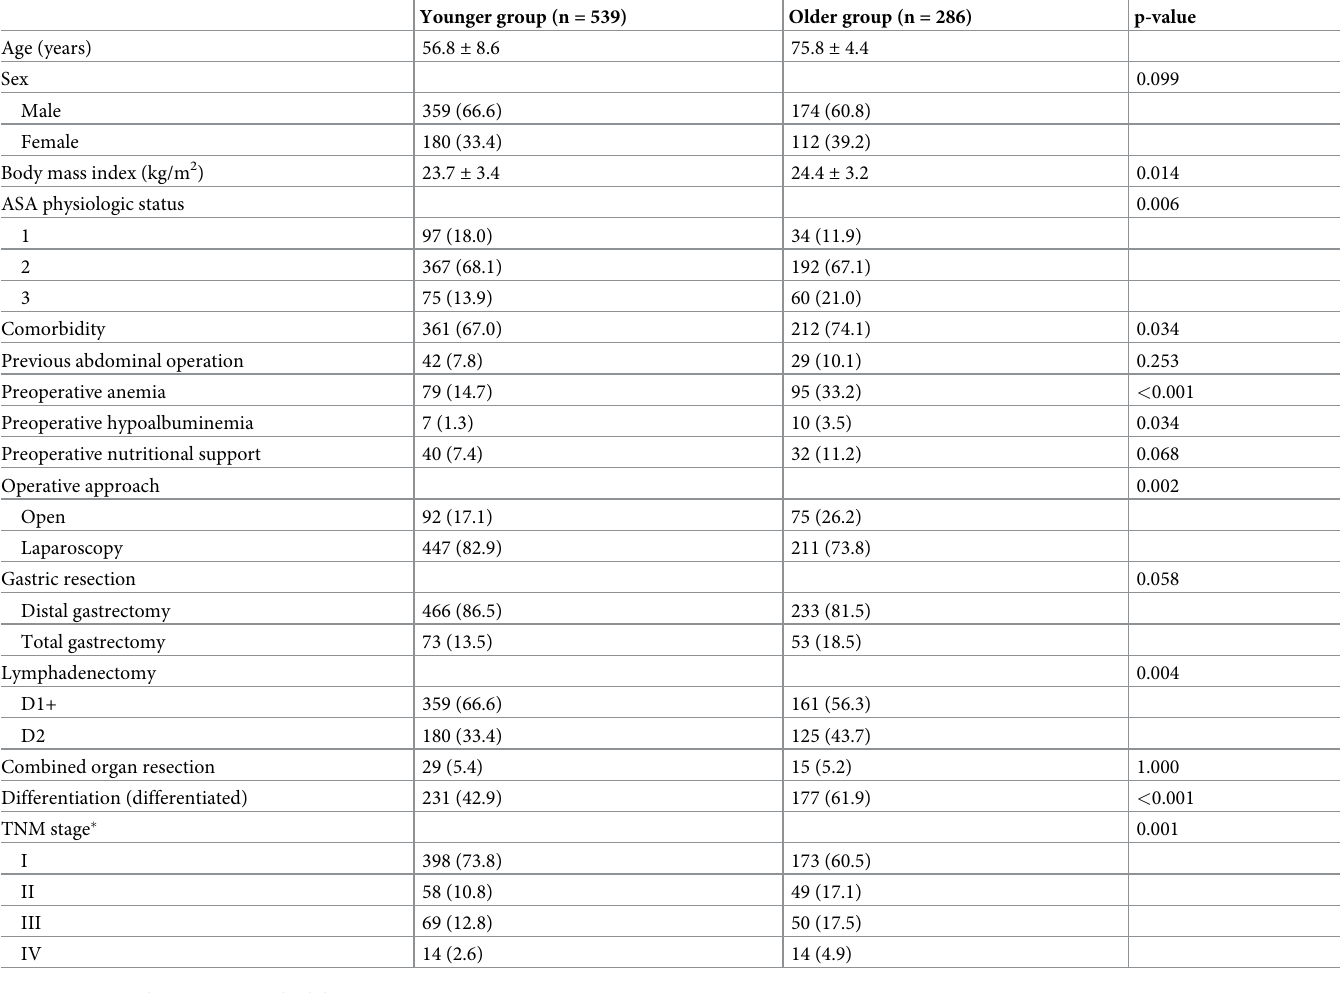
Table 1. Clinicopathological